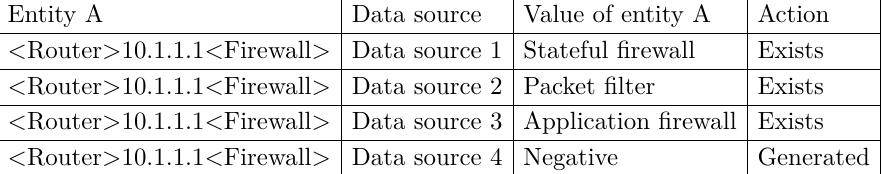
Table 2. Case One: one-to-one relationship where only one claim about an entity can be true